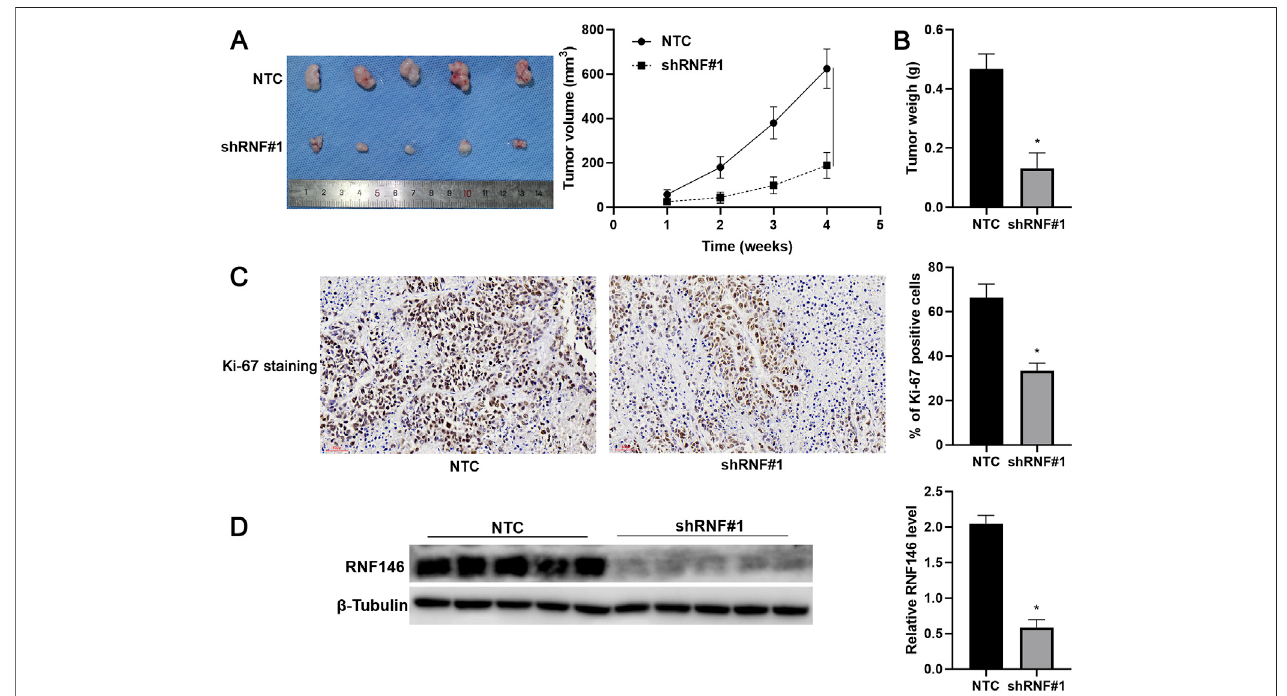
FIGURE 5 | RNF146 knockdown reduces HCC growth in vivo . HCCLM3 cells with or without RNF146 knockdown were subcutaneously injected into nude mice. (A) Tumor volume and (B) weight were consistently reduced by RNF146 knockdown. (C) Tumor tissues from the RNF146 knockdown group showed fewer Ki-67 staining cells compared to the control group. (D) Tumor tissues from the RNF146 knockdown group showed lower RNF146 protein levels than the control group. * p < 0.05.